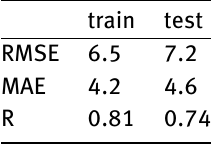
Table 1: Root mean squared errors (RMSE), mean absolute error (MAE) and correlations (R) of the models in test and training